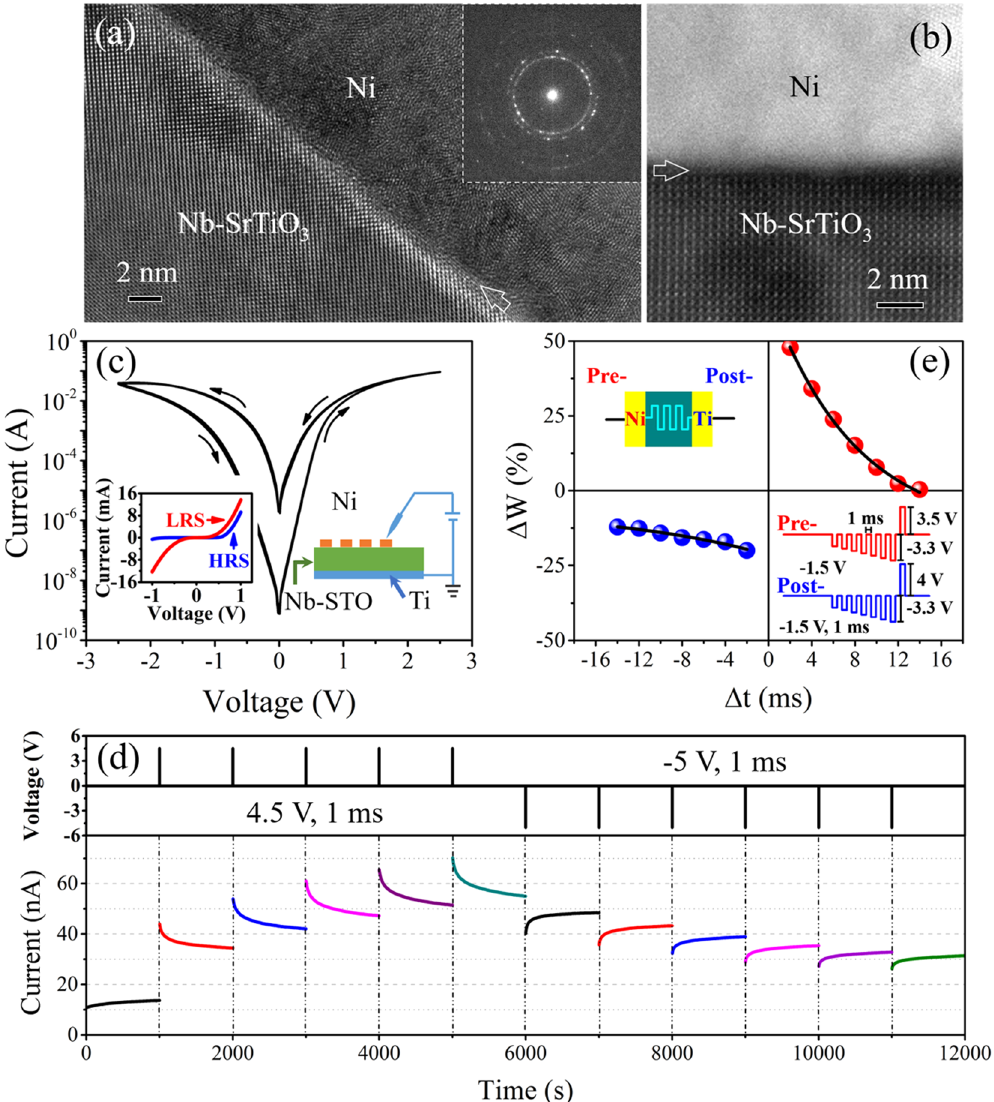
Figure 1. Device structure and electrical characterization. ( a ) HRTEM image of the interface, viewed along the [010] zone axis of Nb-SrTiO 3 . SAED of the Ni electrode in the inset shows the pattern of rings, demonstrating the polycrystalline feature of Ni. ( b ) Atomic-resolution HAADF investigations of the interface, viewed along the [010] zone axis of Nb-SrTiO 3 . ( c ) 50 cycles of current-voltage sweeping of the Ni/Nb-SrTiO 3 /Ti memristive device. The device structure is shown in the right inset. The device in HRS shows obviously rectifying characteristic while the one in LRS does not, as illustrated in the left inset. ( d ) Consecutive change of partially non-volatile conductance after pulse stimuli, exhibiting synaptic plasticity similarity. The read voltage is 0.05 V. ( e ) Change of the device conductance ( Δ W ) vs . the relative timing ( Δ t ) of pre- and post-spike, showing the STDP behavior. The conductance change can be considered as the change of the synaptic